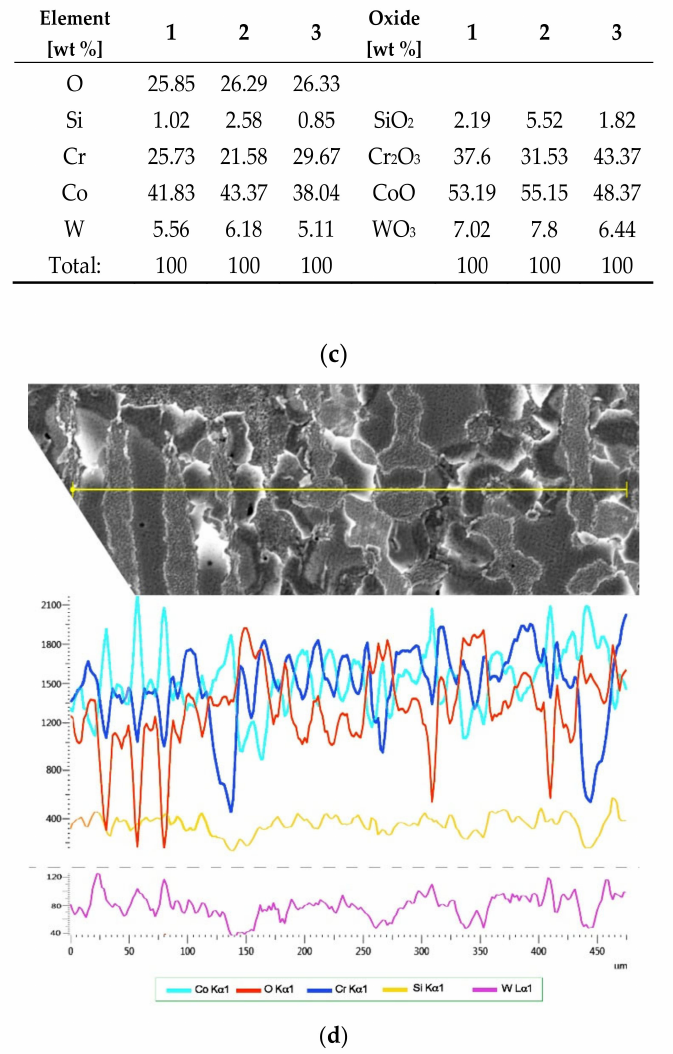
Figure 3. SEM EDS results for the CST1 sample: ( a ) SEM-SE morphology with average EDS results from the marked area; ( b ) maps presenting the surface distribution of O, Co, Cr, W, and Si; ( c ) EDS results for marked points; ( d ) SEM-SE micrograph with corresponding EDS line scan results.